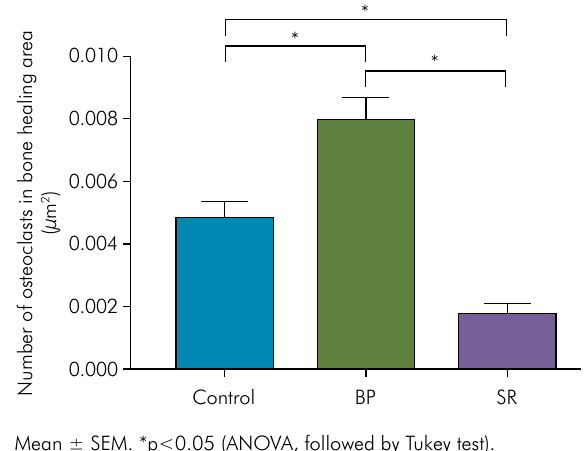
Figure 8. Increased levels of osteoclasts in the BP group.